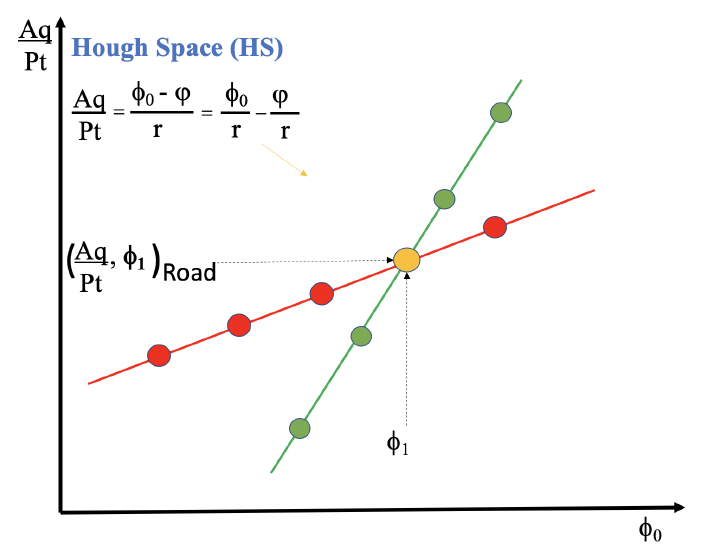
Figure 1. Hough space created via Formula (1).